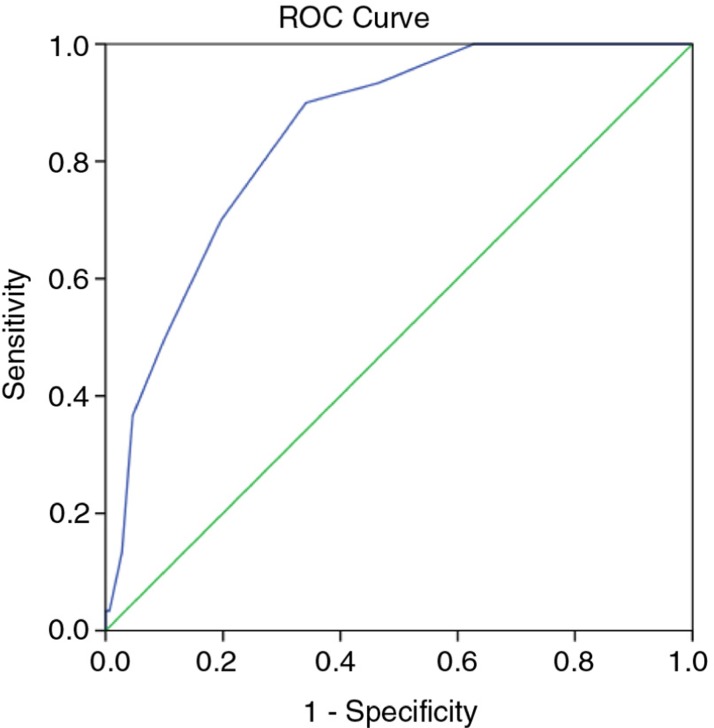
Receiver-operating characteristic (ROC) curve comparing NutricheQ total scores to an objective rating of nutritional risk based on analysis of actual dietary intake and anthropometric measurement using objective criteria. Area under the curve (AUC)=85%.